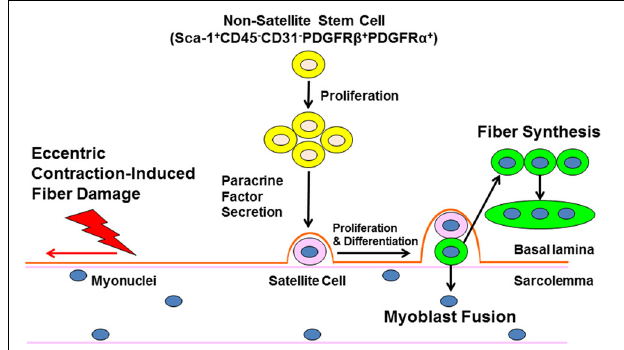
FIGURE 1 | Non-satellite stem cells regulate skeletal muscle repair following eccentric exercise. Ultrastructural damage caused by eccentric exercise stimulates the expansion on non-satellite stem cells in skeletal muscle. Non-satellite stem cells synthesize and release a variety of growth factors and anti-inflammatory cytokines that positively regulate satellite cell proliferation and differentiation. Finally, developing myoblasts fuse with damaged fibers or fuse with other myoblasts to enhance new fiber synthesis. The regulation of non-satellite stem cell function by factors unique to different types of injury and conditions (age, disease) is a current area of